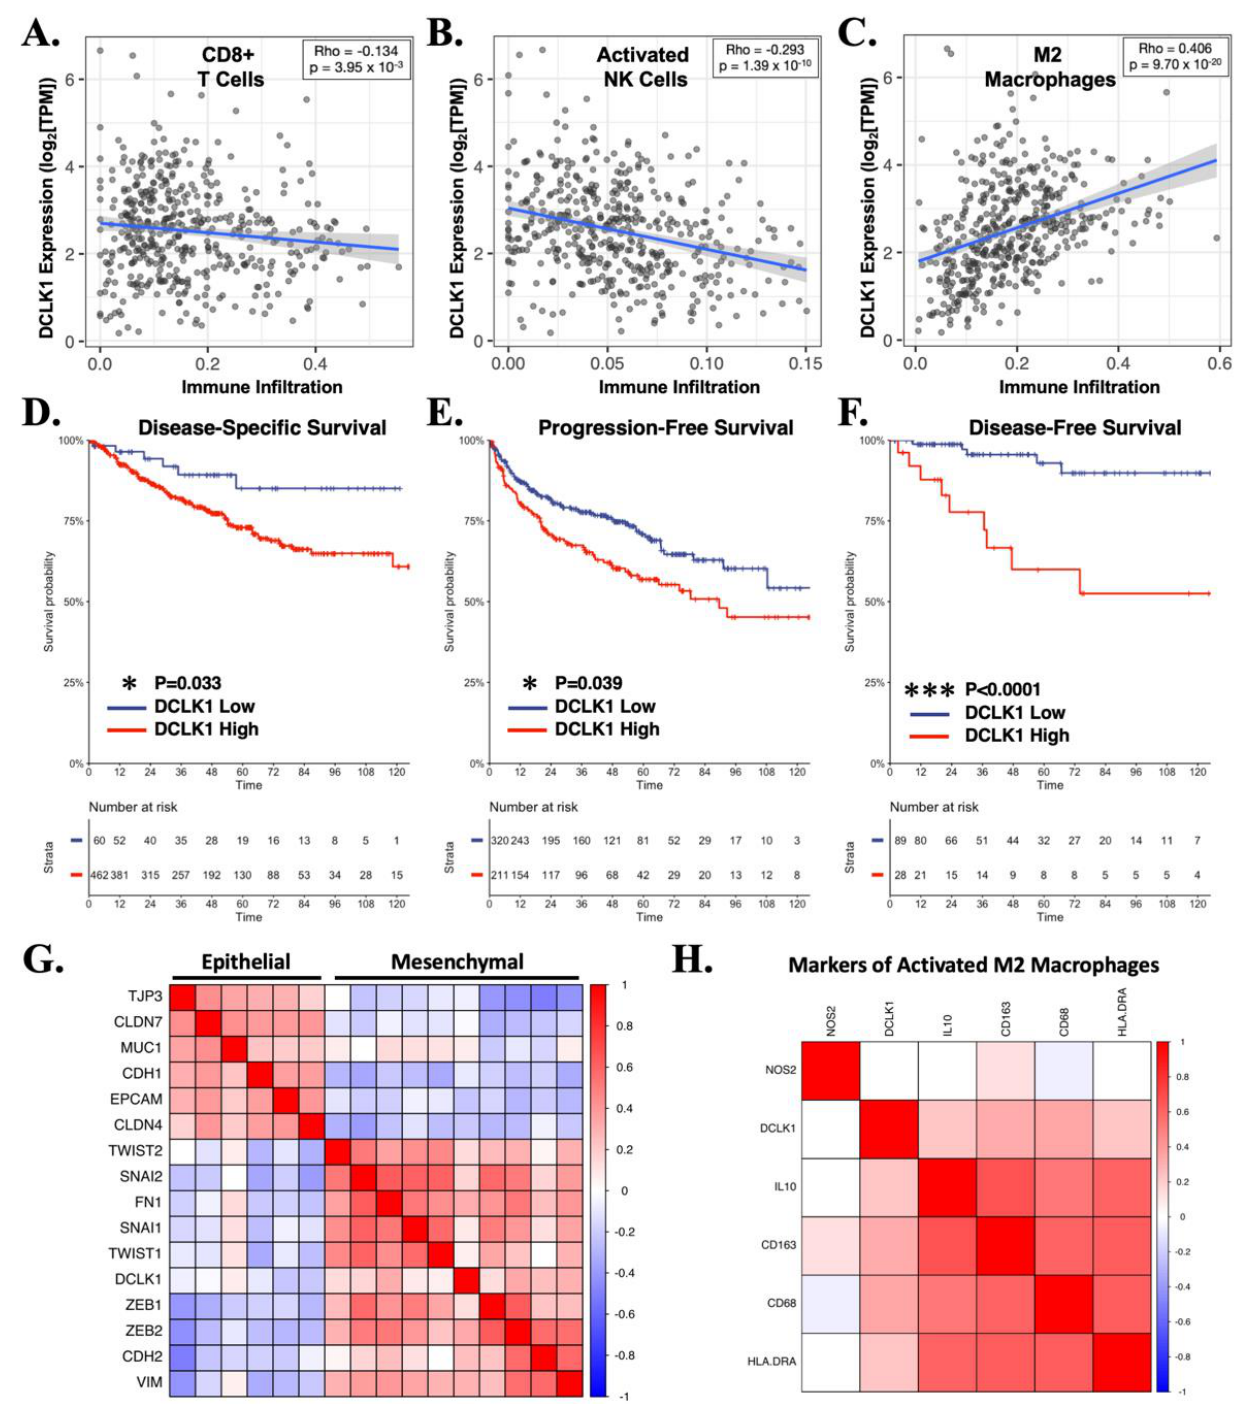
Figure 5. DCLK1 is correlated with an immune excluded/desert phenotype characterized by reduced cytotoxic immune cells and increased M2 macrophages in the human RCC microenvironment. ( A – C ) Cibersort algorithm results from TCGA’s RCC dataset ( n = 533), demonstrating a significant inverse association for DCLK1 with CD8+ cytotoxic T-cells ( p < 0.0005, Spearman r = − 0.134) ( A ) and activated NK cells ( p < 0.0001, Spearman r = − 0.293) ( B ), and a strong positive association with M2 macrophages ( p < 0.0001, Spearman r = 0.406) ( C ). ( D – F ) Survival analysis based on DCLK1 expression from TCGA’s RCC dataset demonstrates significant association with reduced disease-specific (( D ), p < 0.05), progression-free (( E ), p < 0.05), and disease-free (( F ), p < 0.0001) survival. ( G ) Correlation analysis linking DCLK1 expression to an EMT phenotype in TCGA’s RCC dataset. ( H ) Correlation analysis demonstrating DCLK1 (cid:48) s positive association with M2 macrophage markers IL-10, CD68, CD163, and